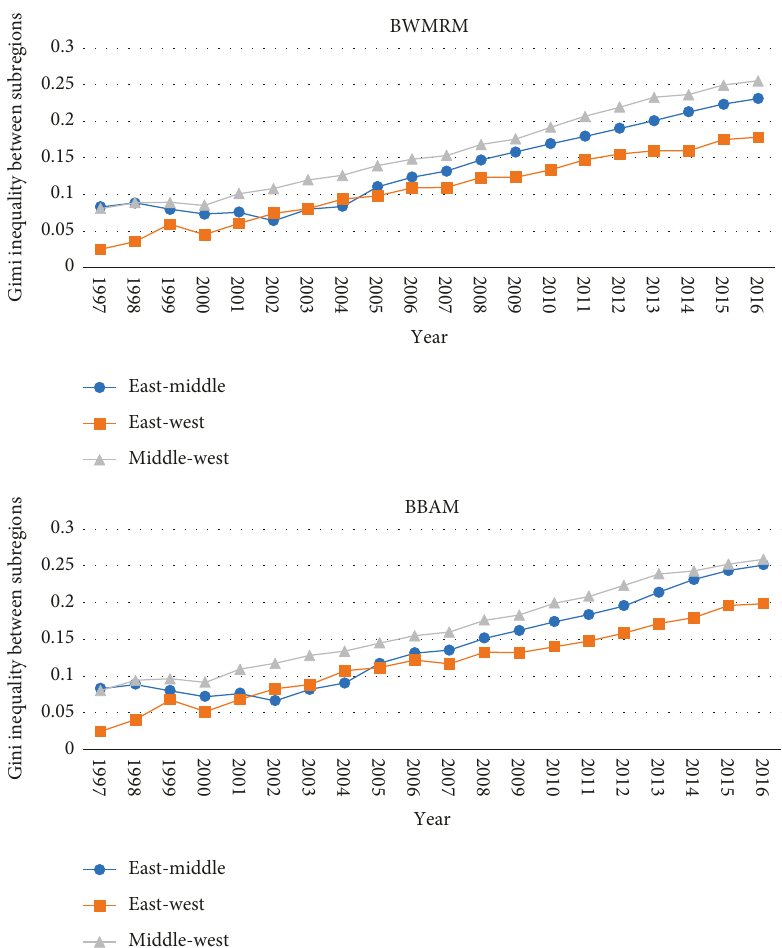
Figure 4: The dynamic change of the net contribution of the extended Gini inequality between subregions of AGTFP in